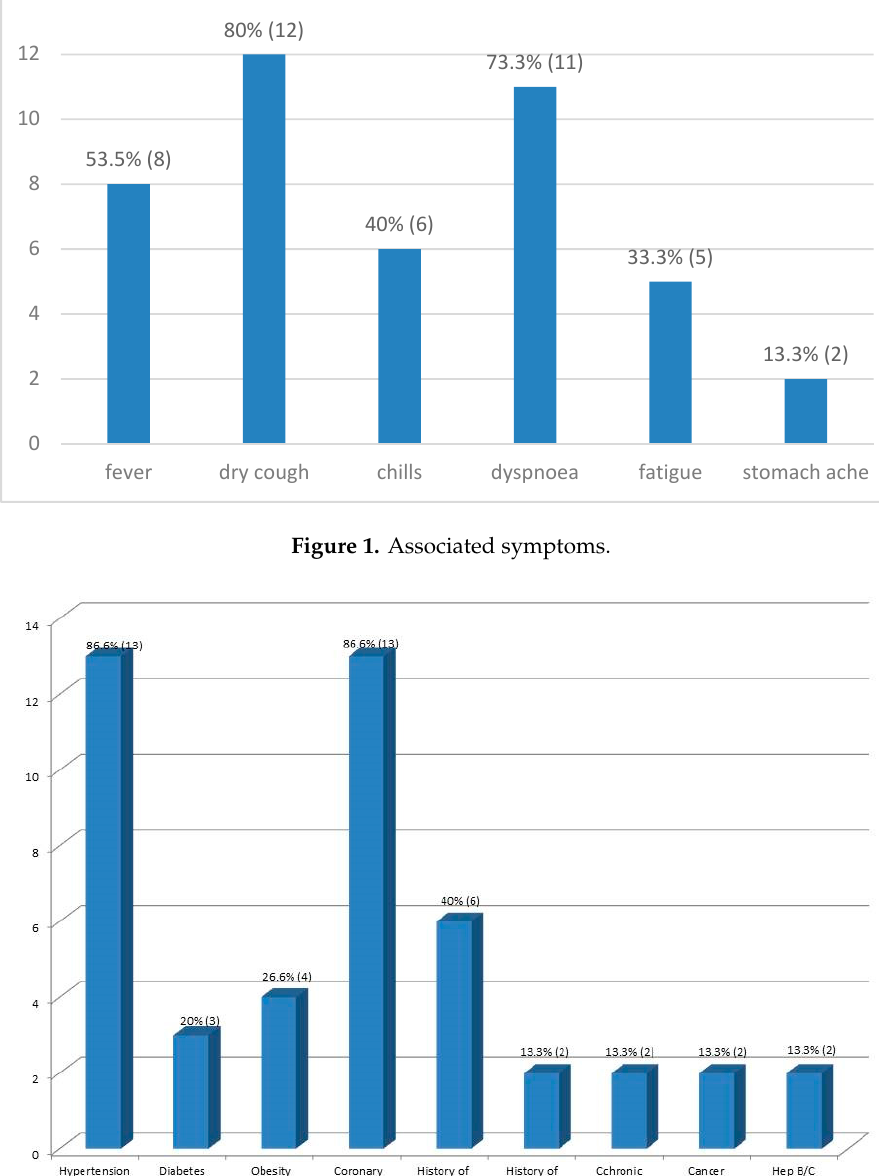
Figure 2. Associated diseases.